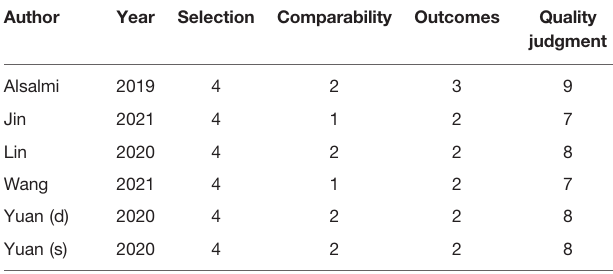
TABLE 2 | Newcastle-Ottawa scale for observational